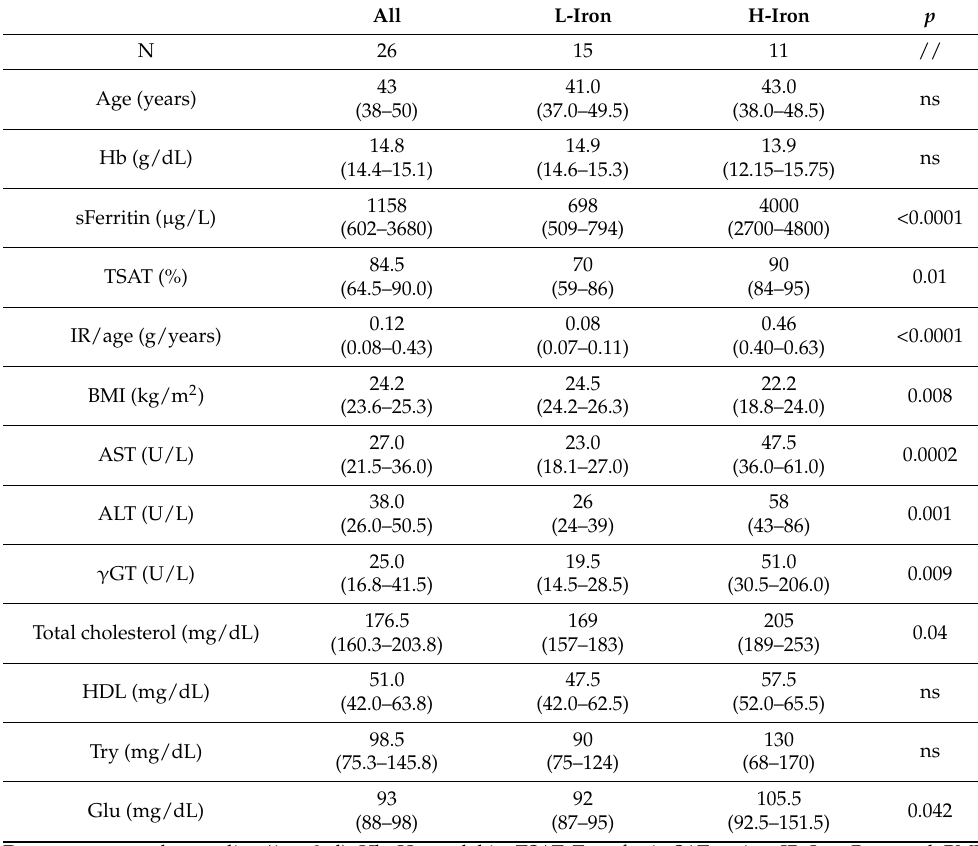
Table 2. Biochemical data of 26 patients divided according to extreme